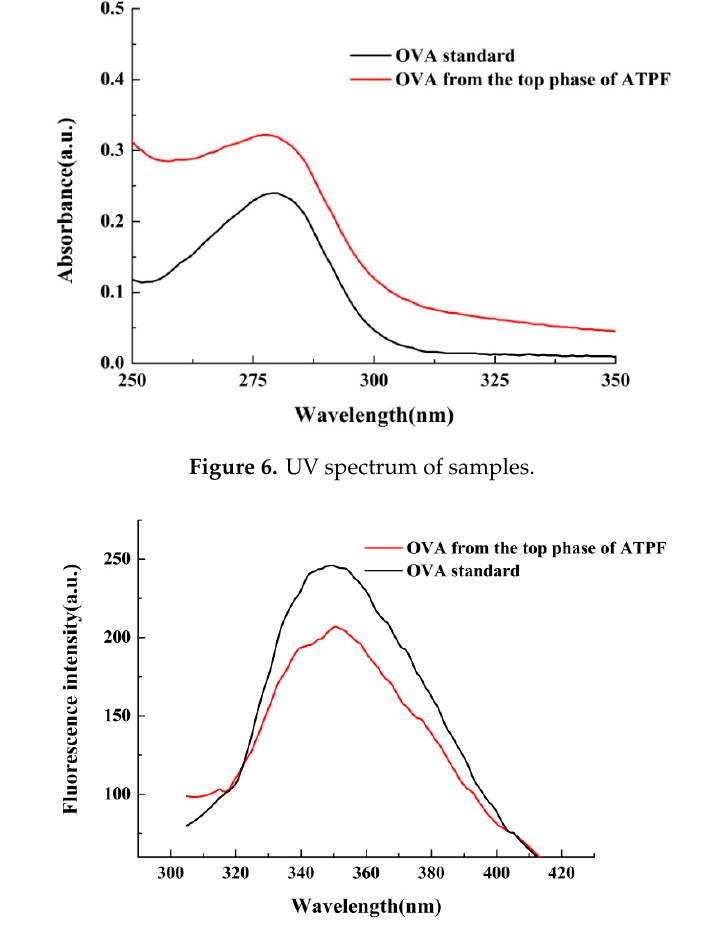
Figure 8 . The content of the secondary structure for OVA obtained from different sources . 3.4. Determination of Ovalbumin Functional Properties The results of functional properties of ovalbumin were shown in Figure 9. There were no significant differences between OVA from the top phase of ATPF and the OVA standard in an oil binding capacity, viscosity, emulsibility and foam capacity. Therefore, the spatial structure of OVA did not change excessively in ATPF and the functional properties of the protein were maintained, meaning that OVA separated from the salted egg white by ATPF could be applied in practice.